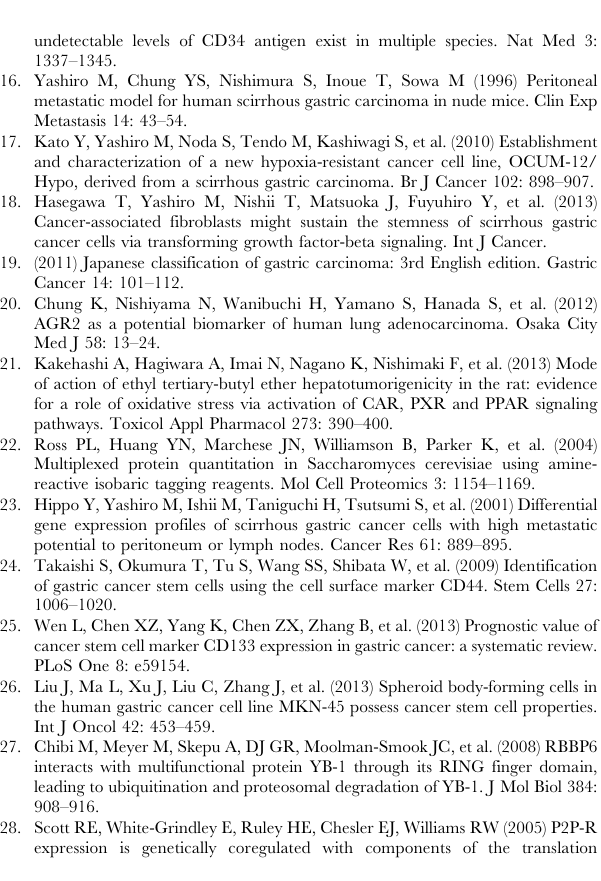
Table S2 Proteins increased in both OCUM-12/SP and OCUM-2MD3/SP